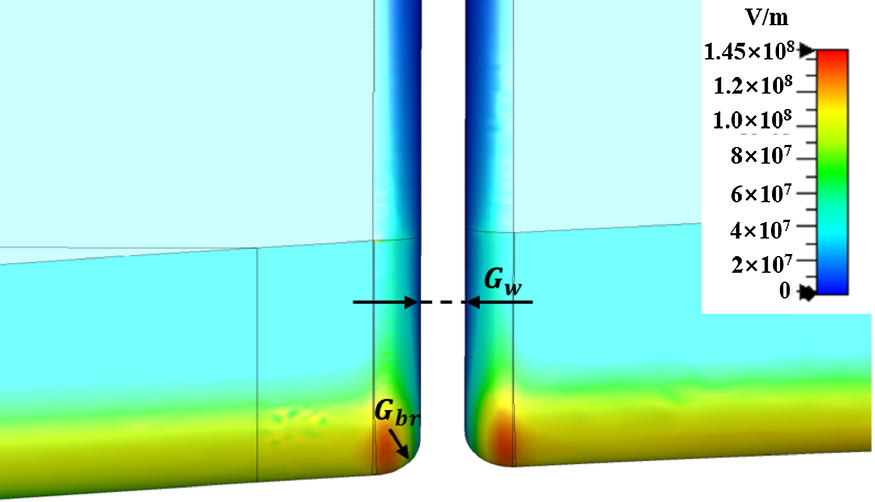
FIG. 17. Geometry of the gap between vane tips ( G w : gap width; G